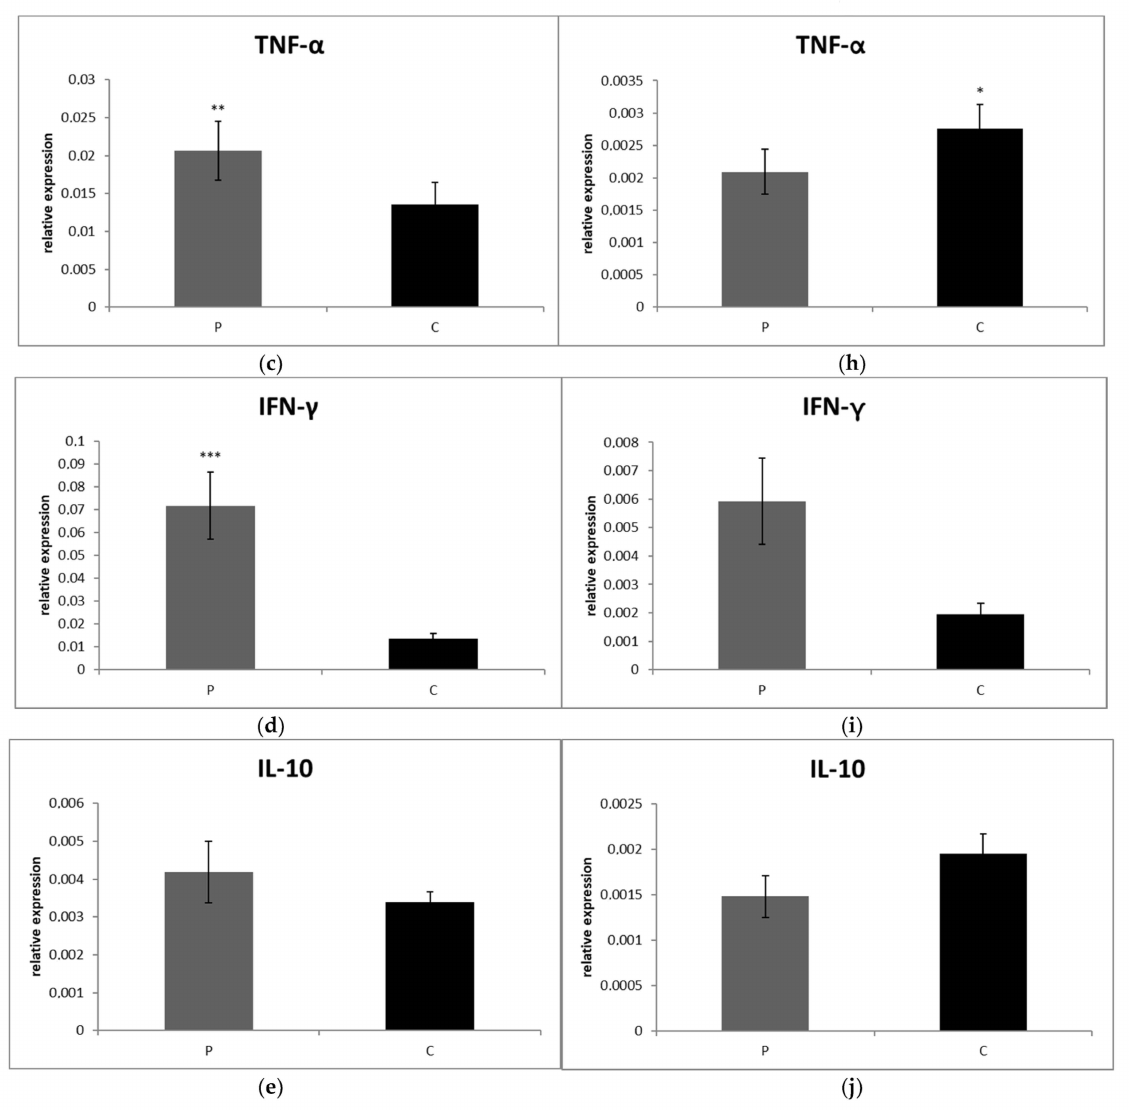
Figure 1. Level of relative gene expression for ( a , f ) IL-1 β , ( b , g ) IL-8, ( c , h ) TNF- α , ( d , i ) IFN- γ ( e , j ) IL-10. Results at each time point are the median of 2 – ∆ Cq . Columns marked with stars are significantly different between groups: * p < 0.05, ** p < 0.01, *** p < 0.001, **** p < 0.0001. P, patients CrCL group; C, control